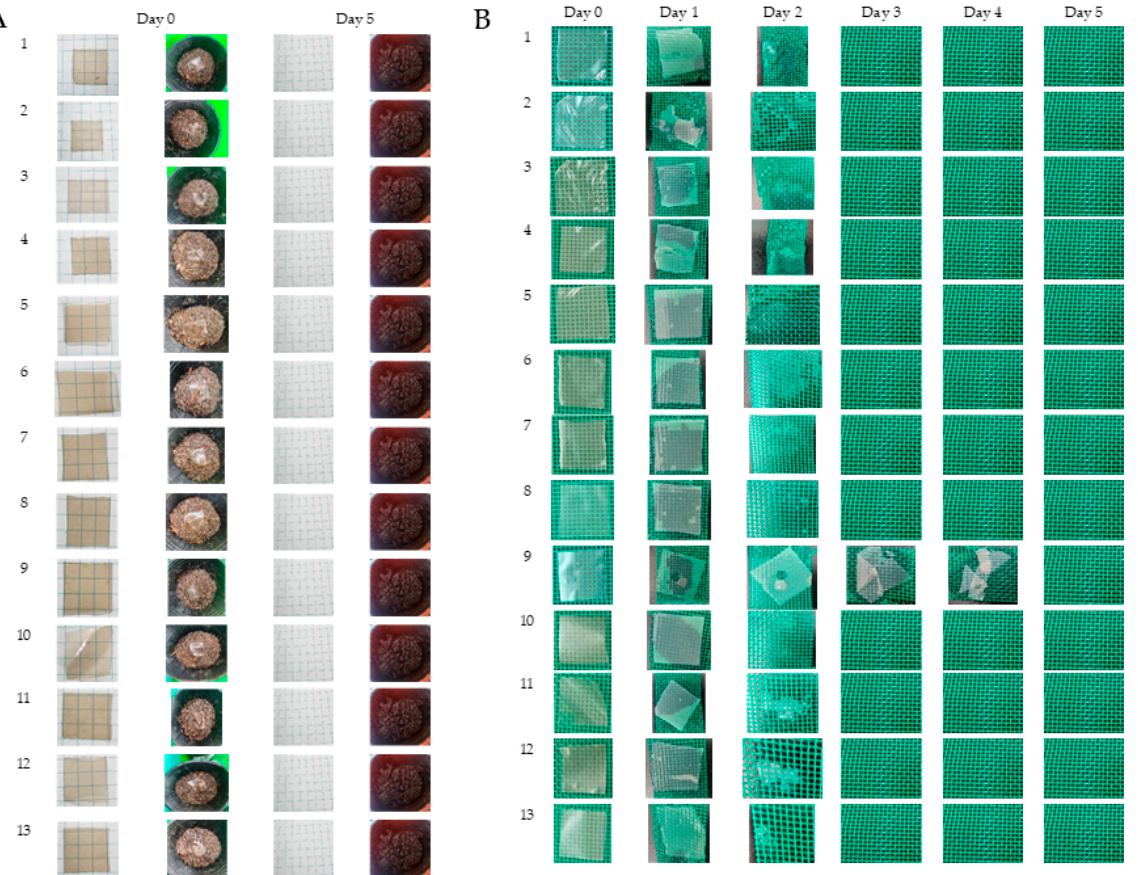
Figure 10. ( A ) Composting soil biodegradability, ( B ) river water biodegradability test of taro peel starch (TPS) films.